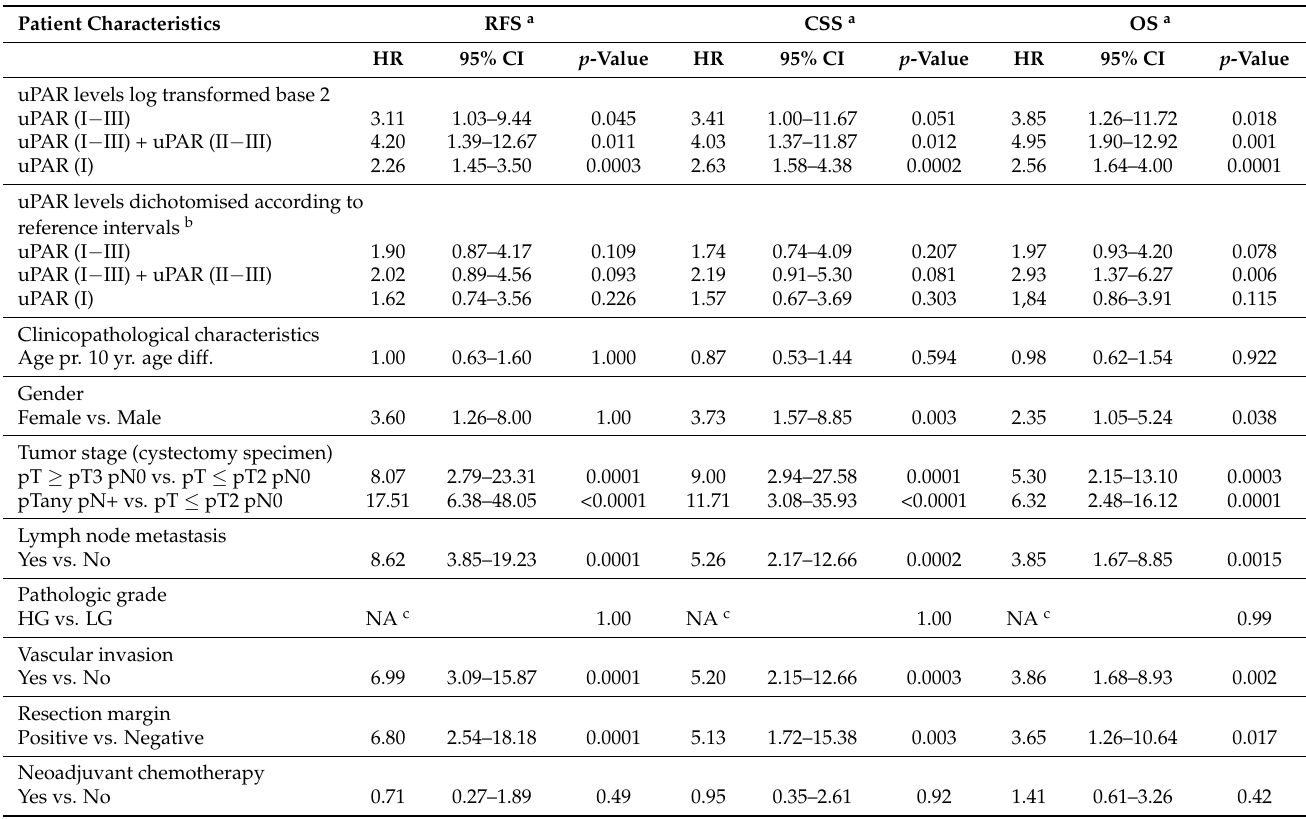
Table 3. Association of the preoperative plasma uPAR forms with clinical outcome (univariate analyses).